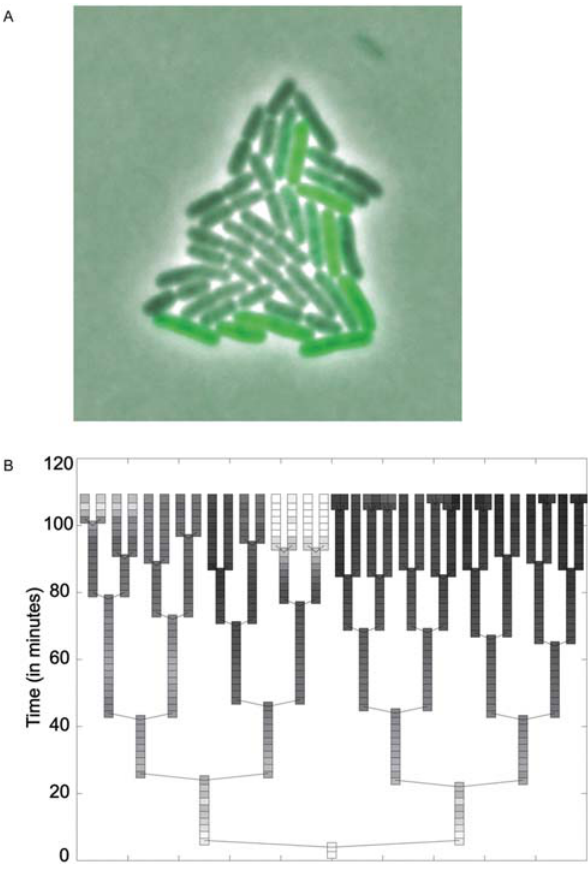
Figure 3. Phenotypic noise in a microcolony in gfp expression from the fliC promoter. A. An image of a microcolony containing the plasmid-borne fliC promoter driving expression of GFP. The colony was started from a single cell and grown for about 6 generations. B. A lineage tree of this microcolony with GFP expression plotted in green (light colored boxes represent high levels of GFP, and dark boxes represent low levels), illustrating the temporal pattern of switching of the fliC promoter. The image and the lineage tree are based on Movie S1.